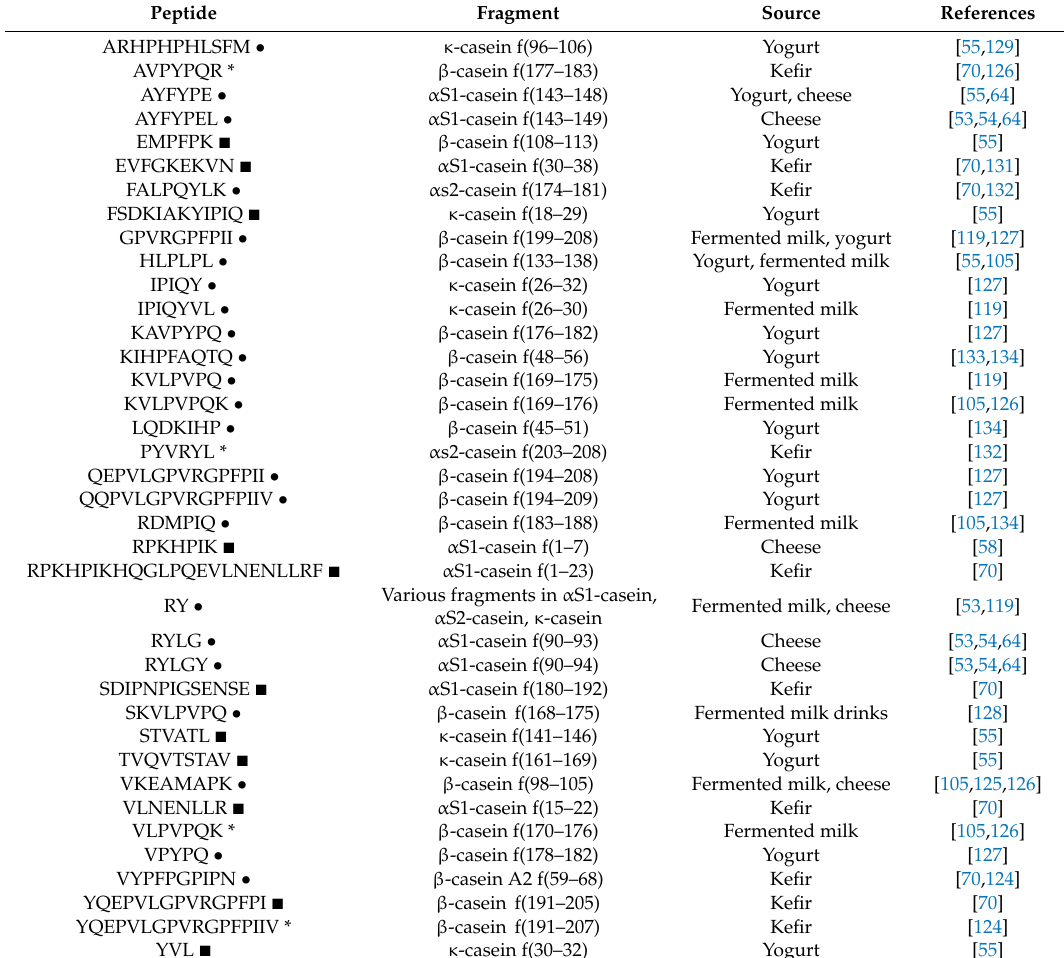
Table 3. Peptides with antioxidant and antimicrobial activities identified in commercial fermented dairy